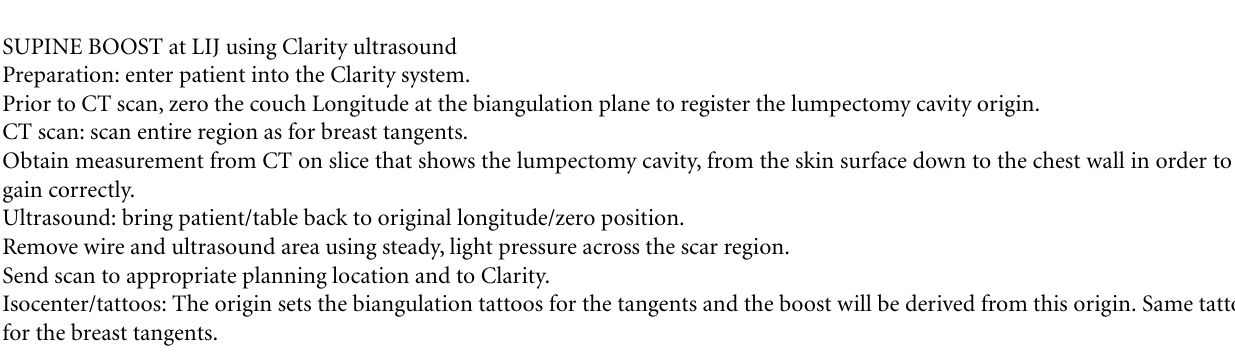
SUPINE BOOST at LIJ using Clarity